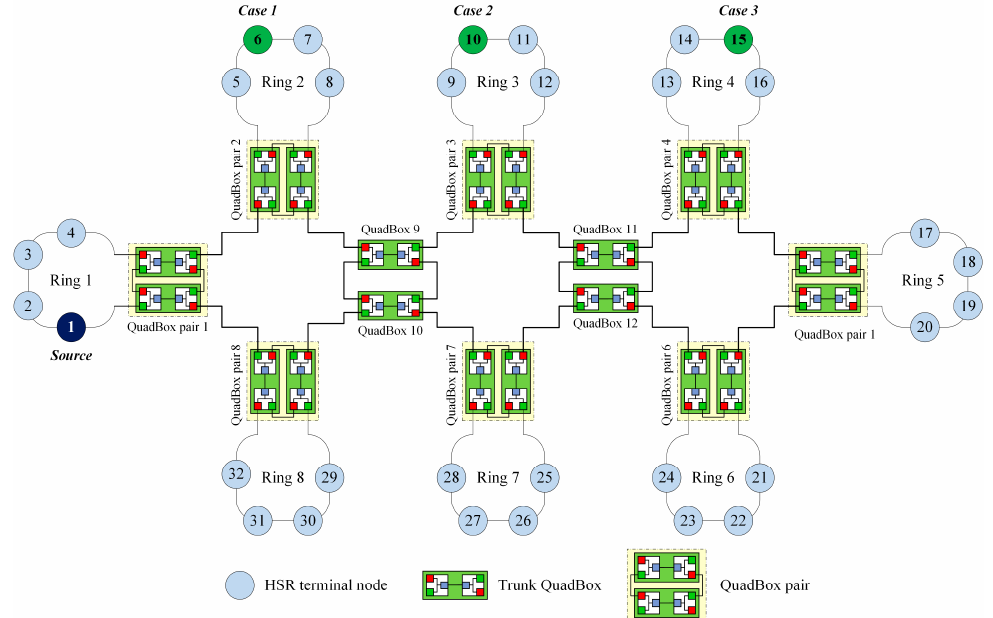
Figure 10. The sample HSR network used in Simulation 2.